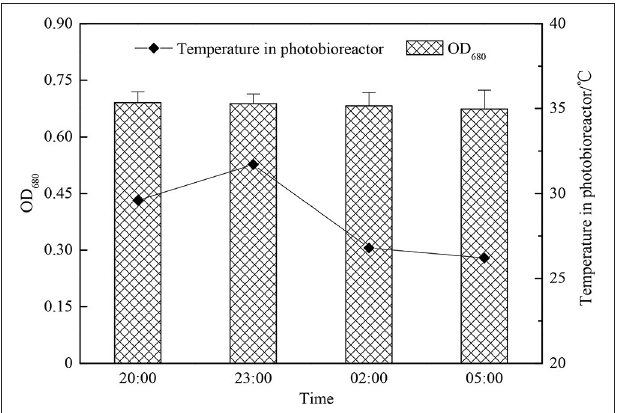
FIGURE 8 | The pH adjustment of Chlorella zofingiensis G1during the night